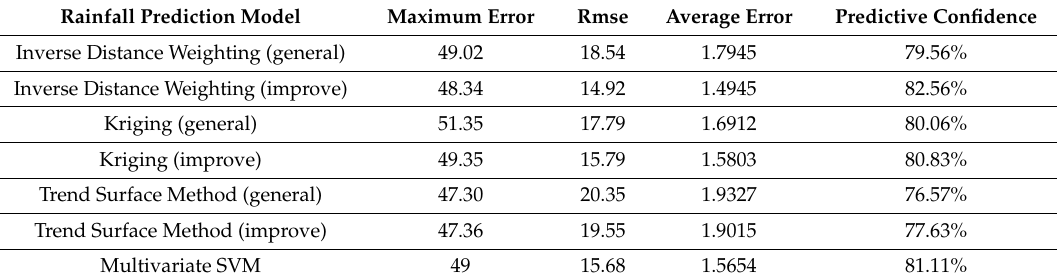
Table 5. Comparison of spatial interpolation methods and multivariate